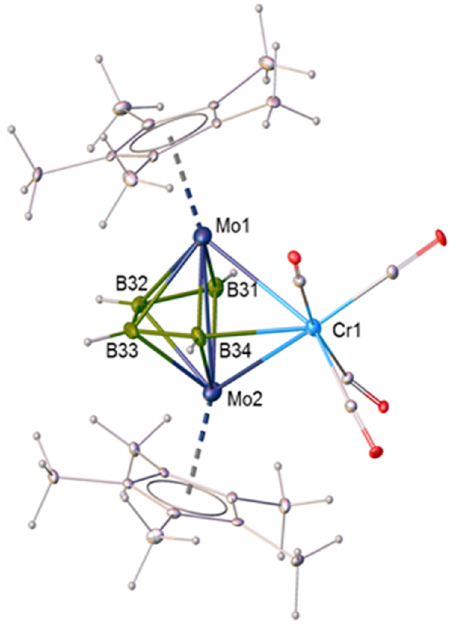
Figure 3. Molecular structure and labeling diagram of 5 . Bridging hydride ligands could not be located. Selected bond lengths (Å) and bond angles ( o ) 5 : Mo1–Mo2 2.821(9), Mo1–Cr1 2.923(13), B31–